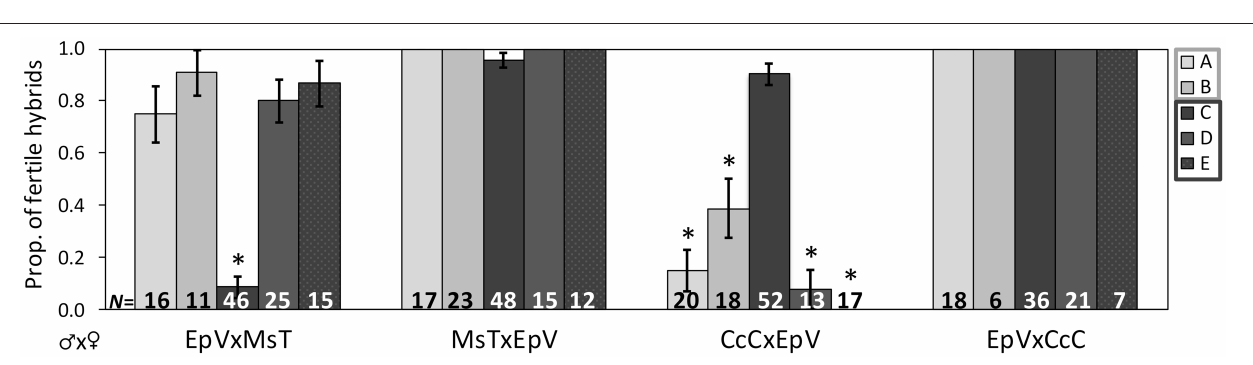
FIGURE 2 | Proportion of F 1 hybrids resulting from crosses between host-foodplant complex sources of Cotesia congregata that produced progeny. Three letter abbreviations denote wasp host species and host-foodplant. Five initial broods of EpV ( Eumorpha pandorus on Virginia creeper) collected at four different locations were crossed with MsT ( Manduca sexta on tobacco) and CcC ( Ceratomia catalpae on catalpa) to produce F 1 hybrids. All F 1 broods were reared on Manduca sexta. Light gray bars (A,B) indicate broods collected in Gloucester Co., VA and dark gray bars (C–E) indicate broods collected in/near Richmond, VA, ∼ 95km apart. Crosses with a significant reduction in fertile hybrids are marked with *(Fisher’s exact test: p < 0.0001); sample sizes of hybrids are at the base. Note the reversal in the pattern for brood C, suggesting that EpV wasps do not cluster exclusively with either MsT or CcC